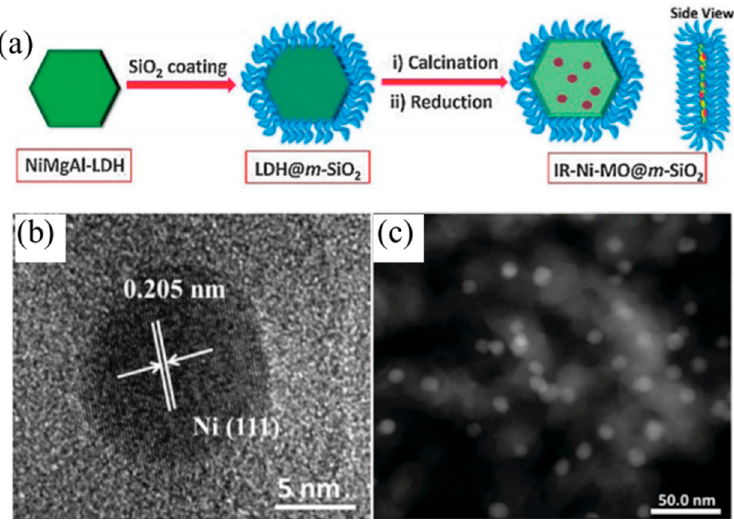
Figure 7. ( a ) Schematic illustration of the preparation process of the modular catalysts. ( b ) TEM image and ( c ) HAADF-STEM image of the modular catalysts [99].